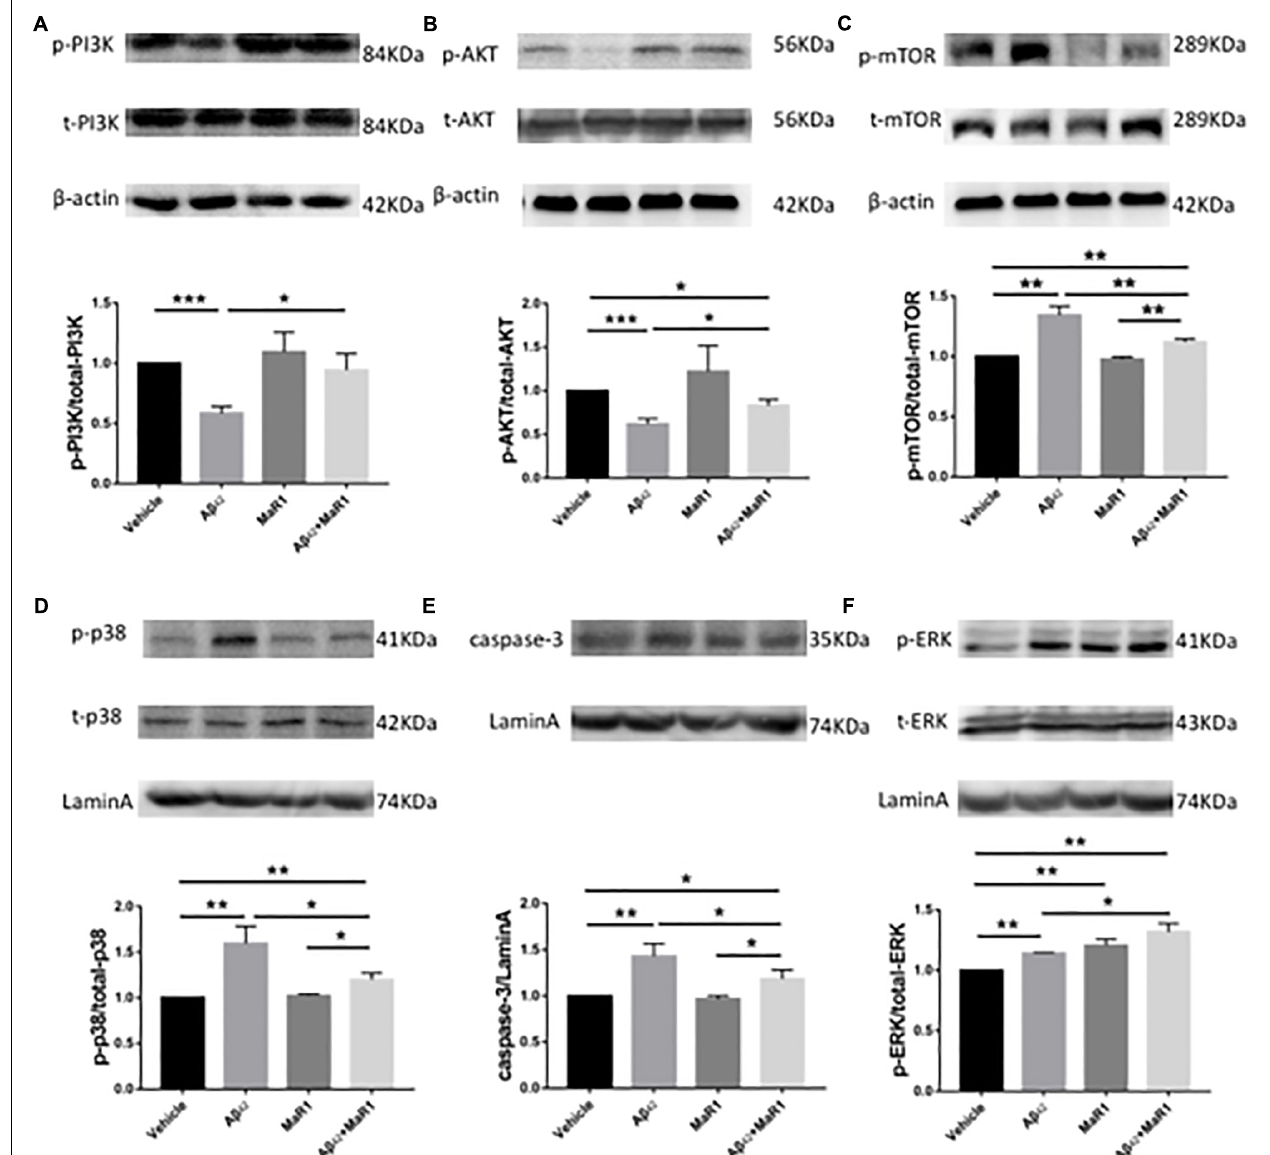
FIGURE 5 | MaR1 altered survival, autophagy, apoptosis, and MAPK signal pathways. Western blots for different proteins and its quantitation in the four groups, PI3K (A) , AKT (B) , mTOR (C) , p38 (D) , caspase 3 (E) , ERK (F) . Compared with Vehicle group, the ratio of p-PI3K/t-PI3K and p-AKT/t-AKT were down-regulated (A,B) , while the ratio of p-mTOR/t-mTOR, p-p38/t-p38, as well as the levels of caspase 3 were up-regulated in A β 42 group ( P < 0.01) (C–E) , however, these A β 42 induced changes were reversed by A β 42 + MaR1 treatment. (F) The ratio of p-ERK/t-ERK was increased by both, A β 42 ( P < 0.001) and MaR1 ( P < 0.01) alone,